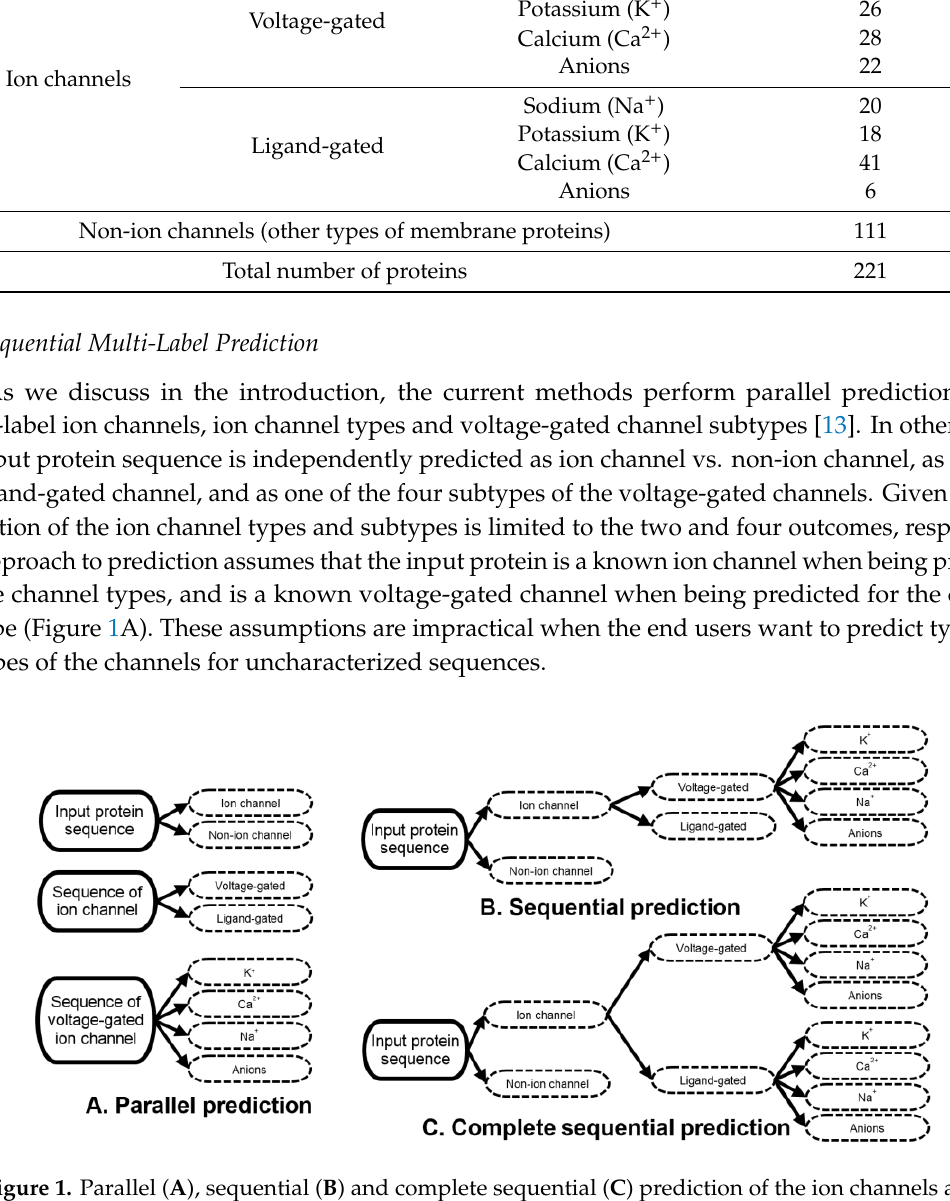
Figure 1. Parallel ( A ), sequential ( B ) and complete sequential ( C ) prediction of the ion channels and their types and subtypes. The solid lines denote inputs while dashed black lines denote putative annotations generated by predictive models.